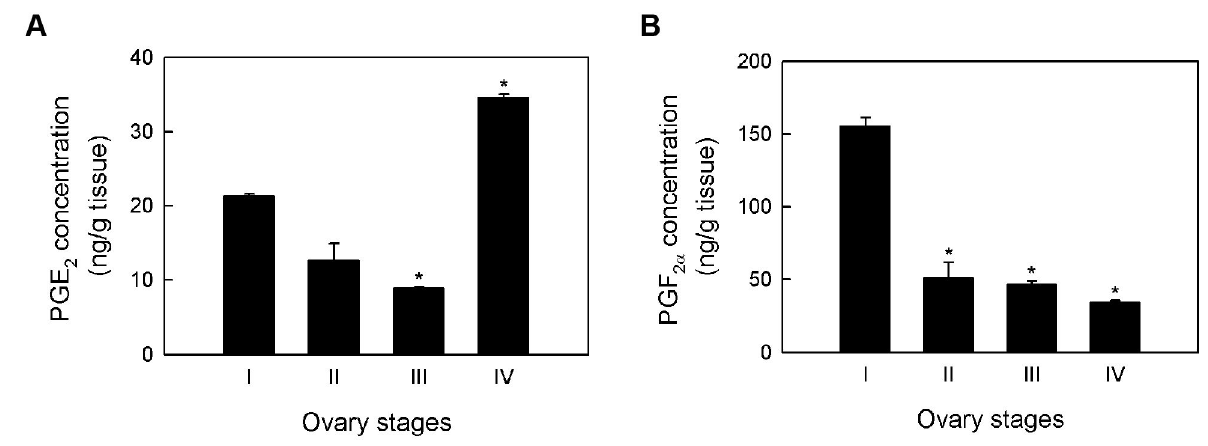
Figure 7. PGE and PGF concentrations in each ovary stage. Shrimp ovaries from each stage were pooled together based on 2 2α the GSI value (N = 3 for each ovary stage) and homogenized. The amounts of (A) PGE enzyme immunoassay. Error bars indicate the standard deviation from the means. These graphs are representatives of two independent experiments that yielded similar results.